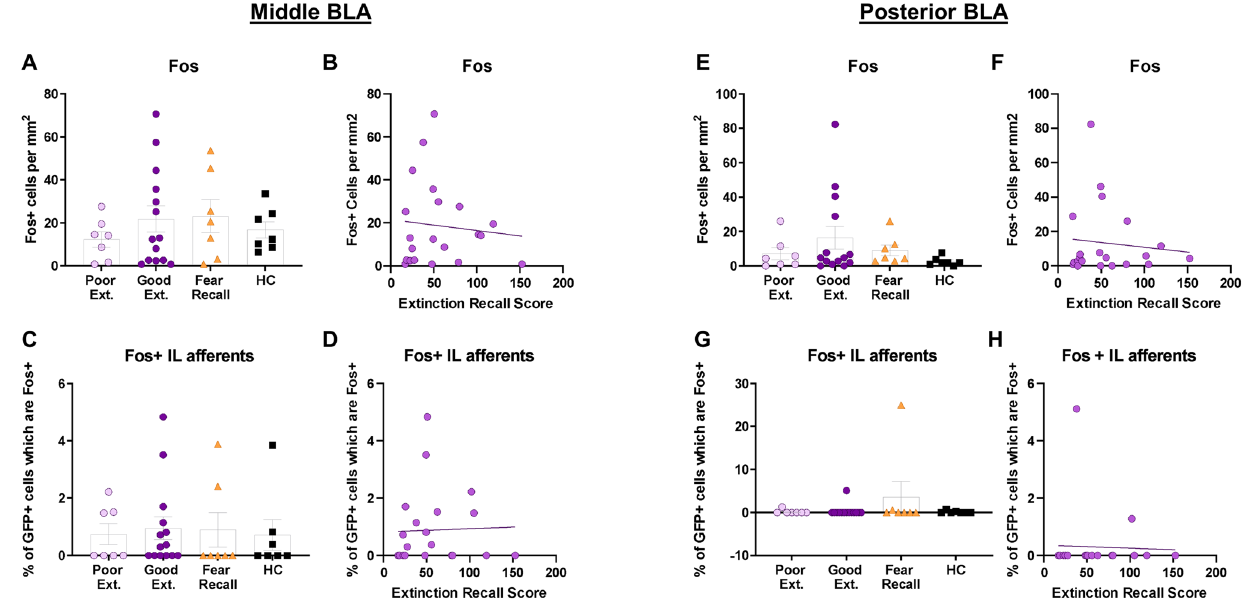
Figure 6. Individual variation in extinction recall does not map onto differences in Fos expression in the basolateral amygdala. ( A ) No significant differences among groups in Fos expression in the mBLA. ( B ) No significant correlation between Fos expression and extinction recall in the mBLA. ( C ) No significant differences among groups in Fos expression within the IL-afferents of the mBLA. ( D ) No significant correlation between Fos expression within the IL-afferents and extinction recall in the mBLA. ( E ) No significant differences among groups in Fos expression in the pBLA. ( F ) No significant correlation between Fos expression and extinction recall in the pBLA. ( G ) No significant differences among groups in Fos-expression within IL-afferents of the pBLA. ( H ) No significant correlation between Fos expression within IL-afferents and extinction recall in the pBLA. Error bars represent standard error of the